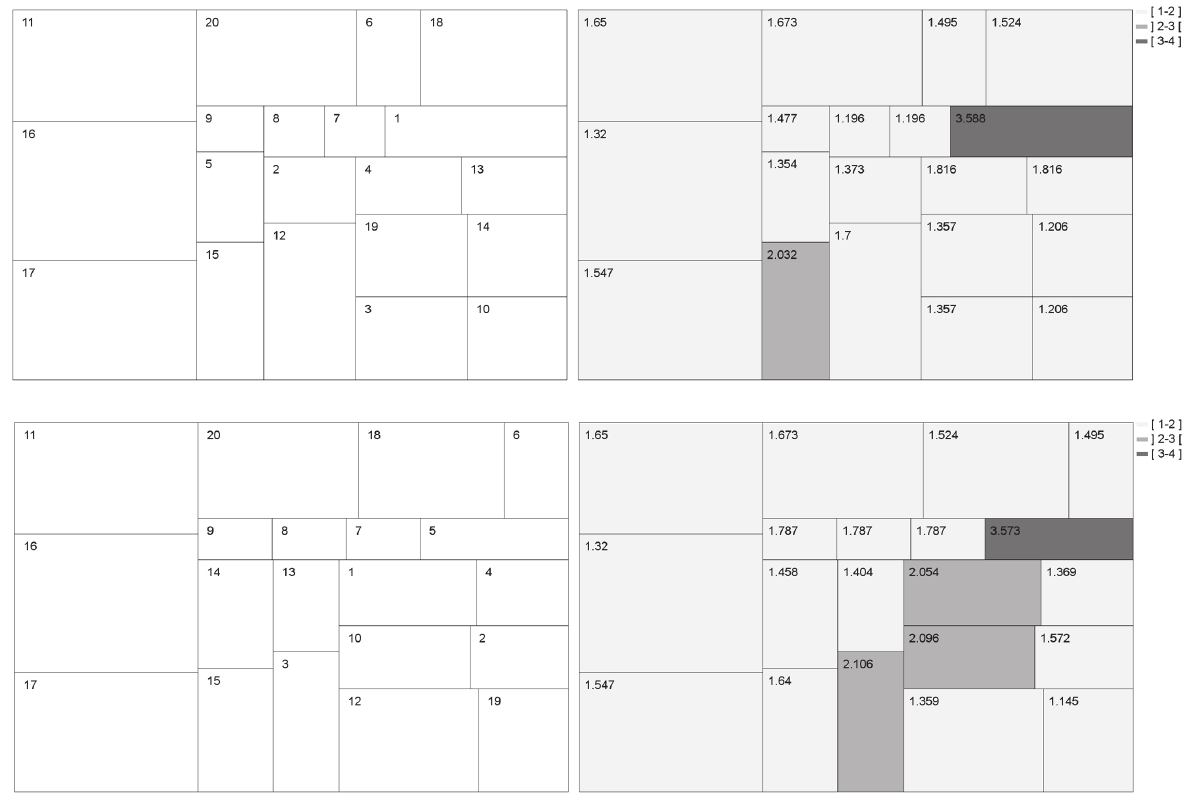
Fig. 3. Block layouts corresponding to the optimal solutions obtained